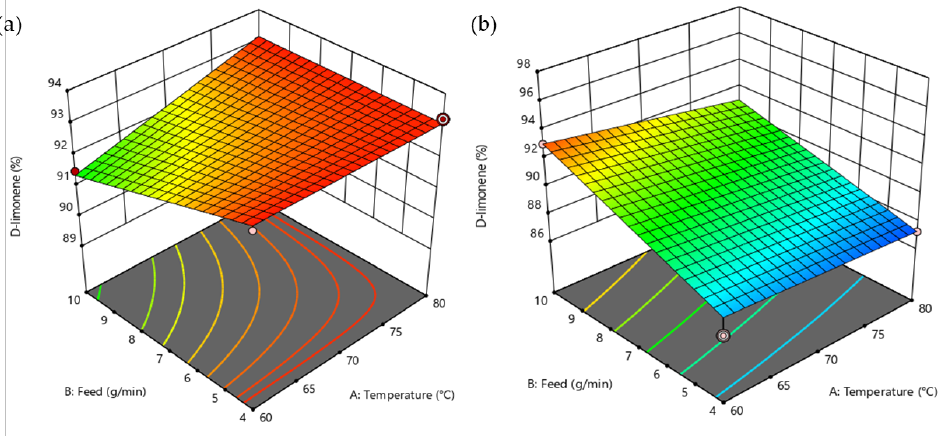
Figure 4. Response-surface representations in fractional distillation. ( a ) D-Limonene (%) in distillate and ( b ) D-Limonene (%) in residue.